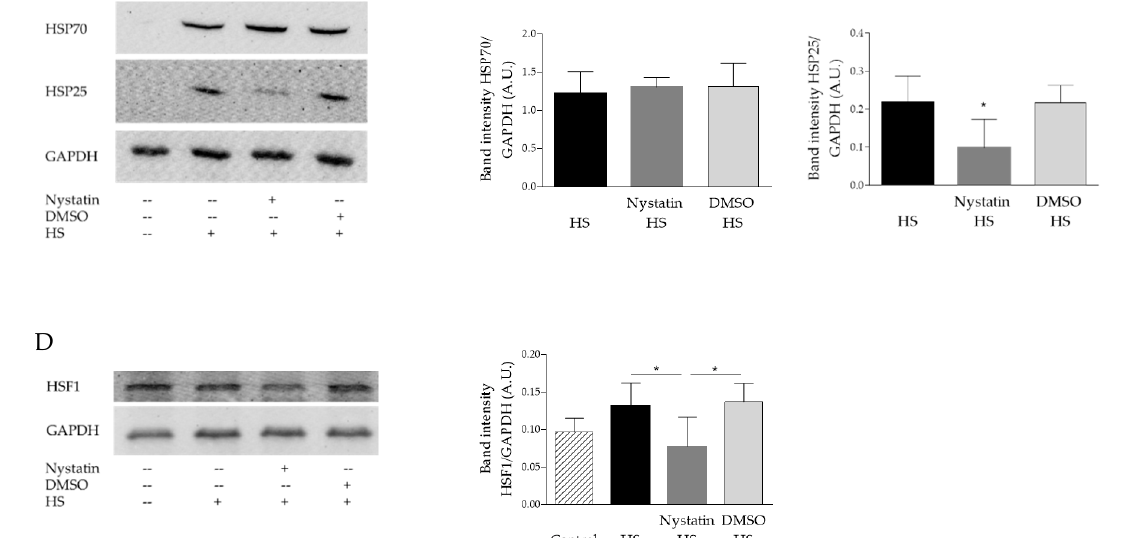
Figure 1. Effect of PM modulation on heat-induced heat shock response. ( A ) B16-F10 cells were incubated for 10 min with 10 mM Methyl- β -cyclodextrin (M β CD) at 37 °C followed by 30, 60, or 90 min of heat stress at 42 °C and 3 h recovery at 37 °C; ( B ) B16-F10 cells were incubated for 2, 5, or 10 min with 10 mM M β CD at 37 °C followed by 1 hour heat shock at 42 °C; ( C ) B16-F10 cells were exposed for 1 h to 50 µg/mL nystatin at 37 °C followed by 1 h heat stress at 42 °C and 3 h recovery at 37 °C; ( D ) B16-F10 cells were exposed for 1 h to 50 µg/mL nystatin at 37 °C followed by heat stress for 1 h at 42 °C. Bar graphs show quantified band intensities normalized to GAPDH ( n = 3). CD (X): cells exposed for 2, 5, or 10 min to M β CD. DMSO was treated as a vehicle control for nystatin. A.U.: arbitrary units, HS: heat shock.